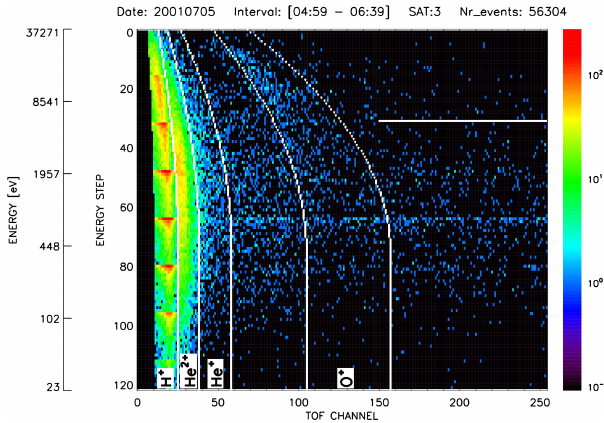
Figure 6. Raw events as a function of TOF and E/q for the 5 July 2001